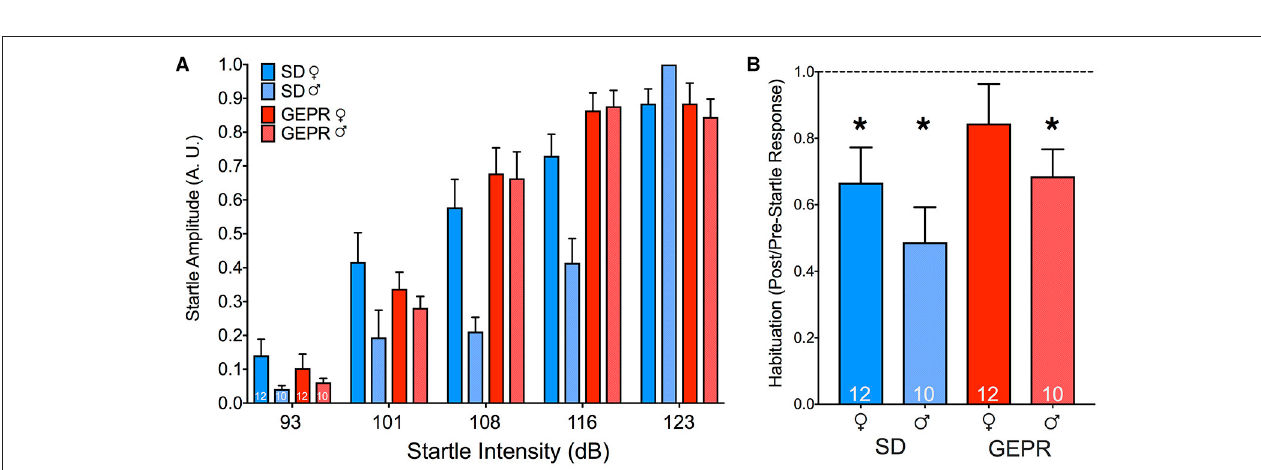
FIGURE 5 | Acoustic startle response and habituation. (A) Startle amplitude (A.U.) as a result of increasing noise burst intensity (dB). We found a main effect of noise intensity [ F (1.6,64.6) = 23.4, P = 0.0000001], but no effect of either strain or sex ( Ps = 0.5 and 0.9, respectively). (B) Habituation to the startling stimulus was present in all groups, except for the female GEPR-3s (* P < 0.01, one sample t -test when compared to the theoretical mean of 1.0). Figures show mean and standard error of the